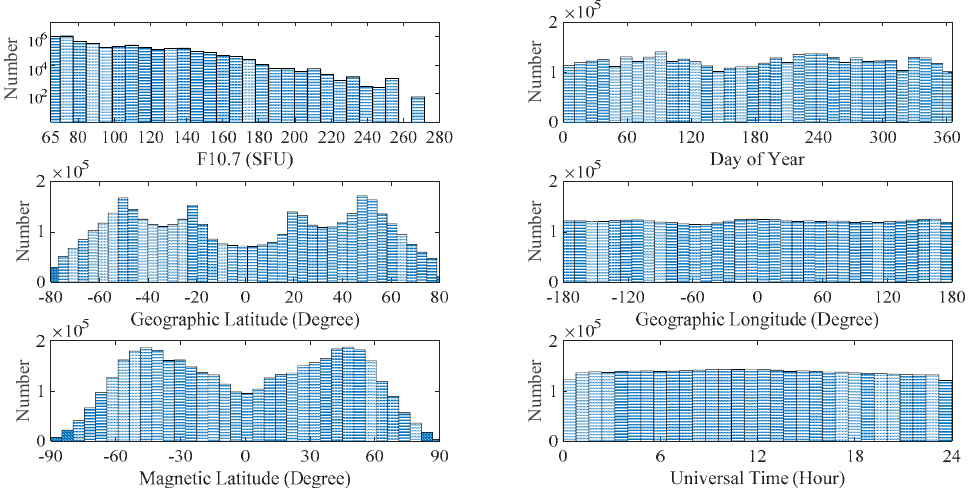
Figure 1. Data distributions with F10.7, day of year, geographical latitude, geographical longitude, magnetic latitude, and universal time.